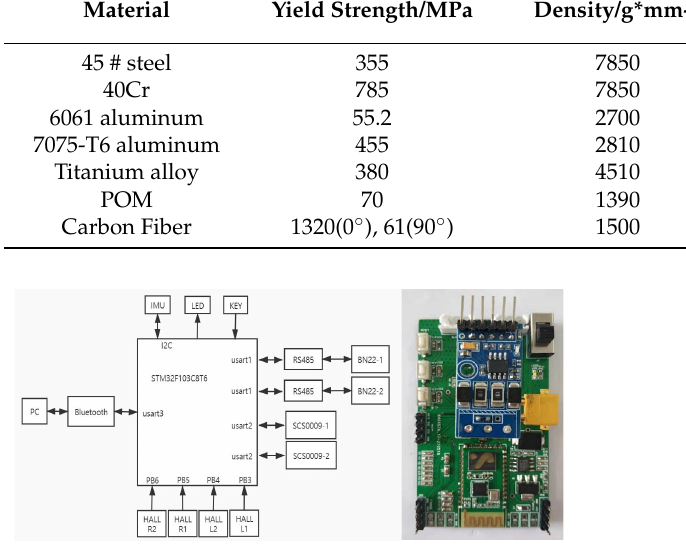
Figure 11. Hardware circuit block diagram and circuit board.